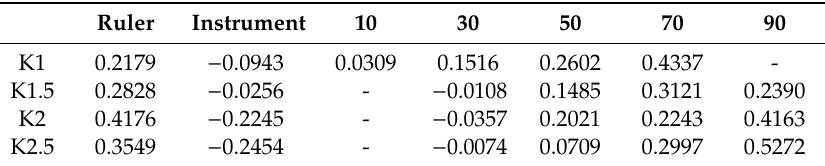
Table 7. The optimal weights in data fusion